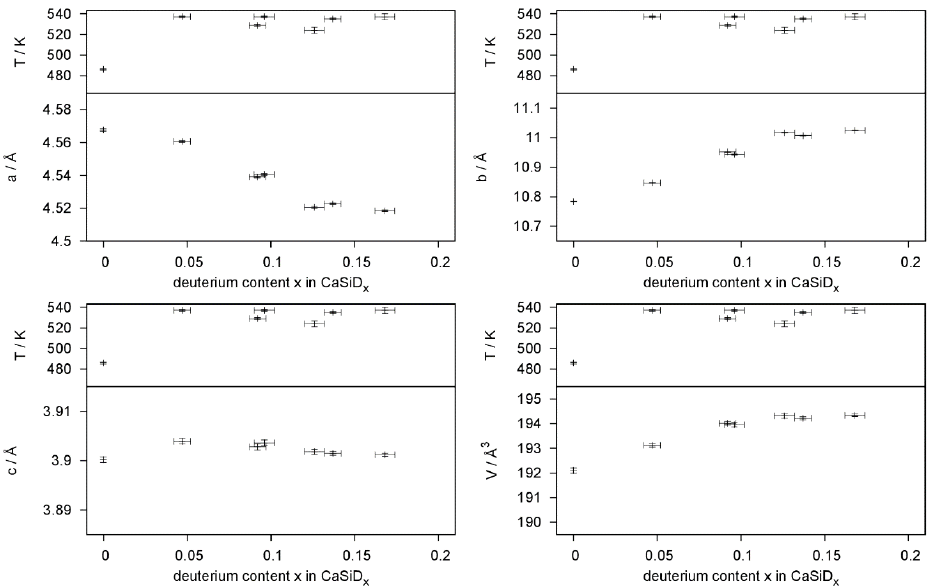
Figure 9. Change of lattice parameters and unit cell volume with respect to the deuterium incorporation.